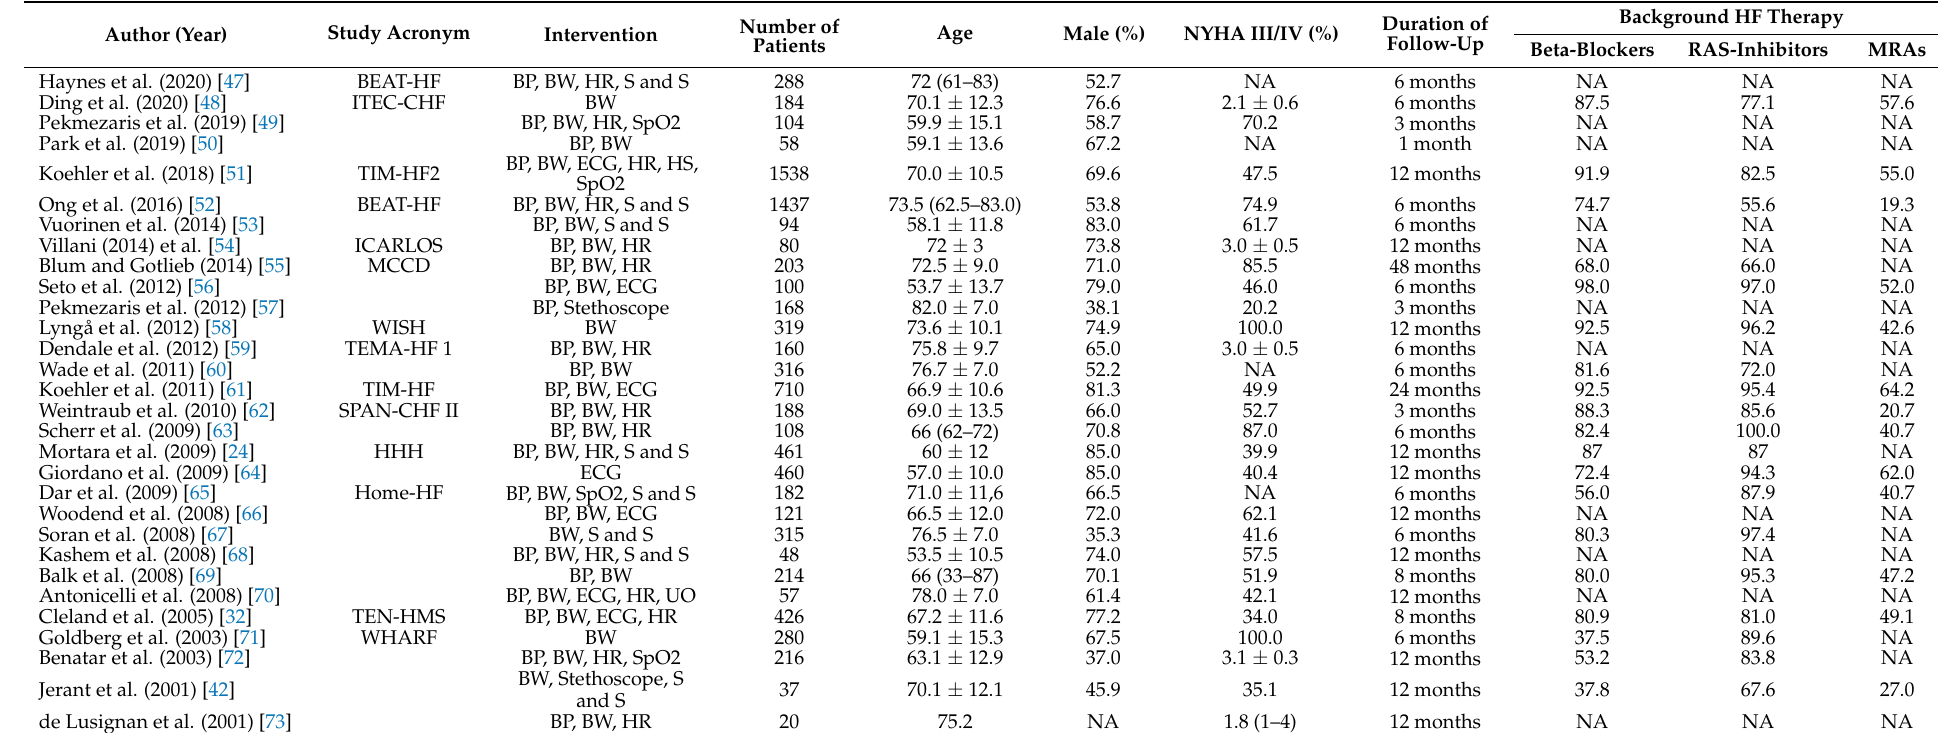
Table 3. Baseline characteristics and background HF therapy in studies investigating non-invasive telemonitoring in HF